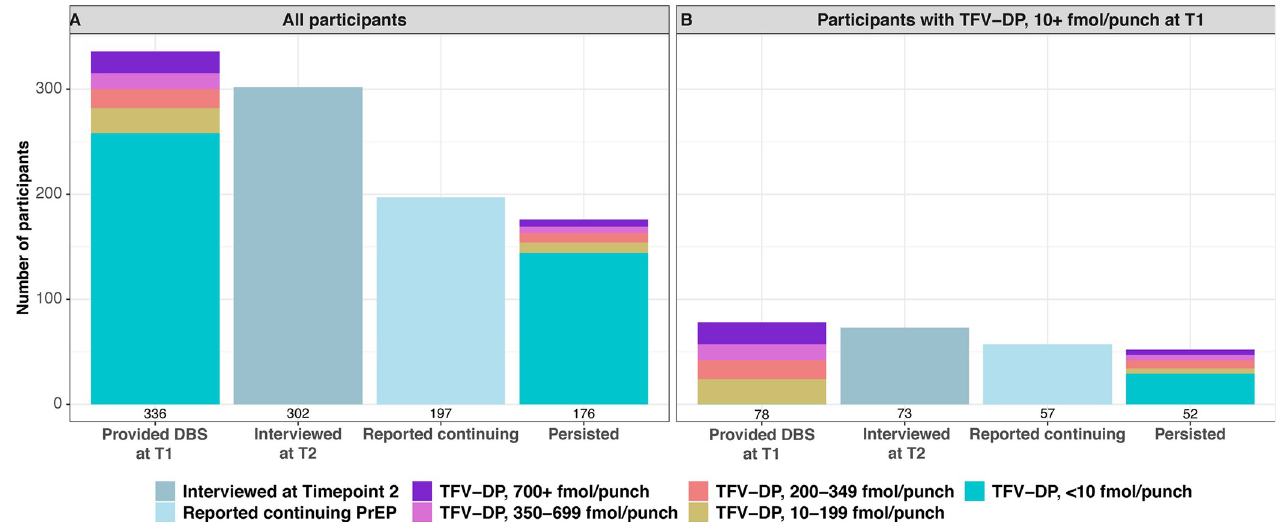
Fig 2. PrEP Cascade. (A) All participants. (B) Participants with detectable TFV-DP levels (10+ fmol/punch) at the first Interview. T1: first interview visit (Time point 1). T2: second interview visit (Time point 2). The numbers of participants in the categories of TFV-DP levels are shown in S1 Table. PrEP, pre-exposure prophylaxis; TFV-DP,